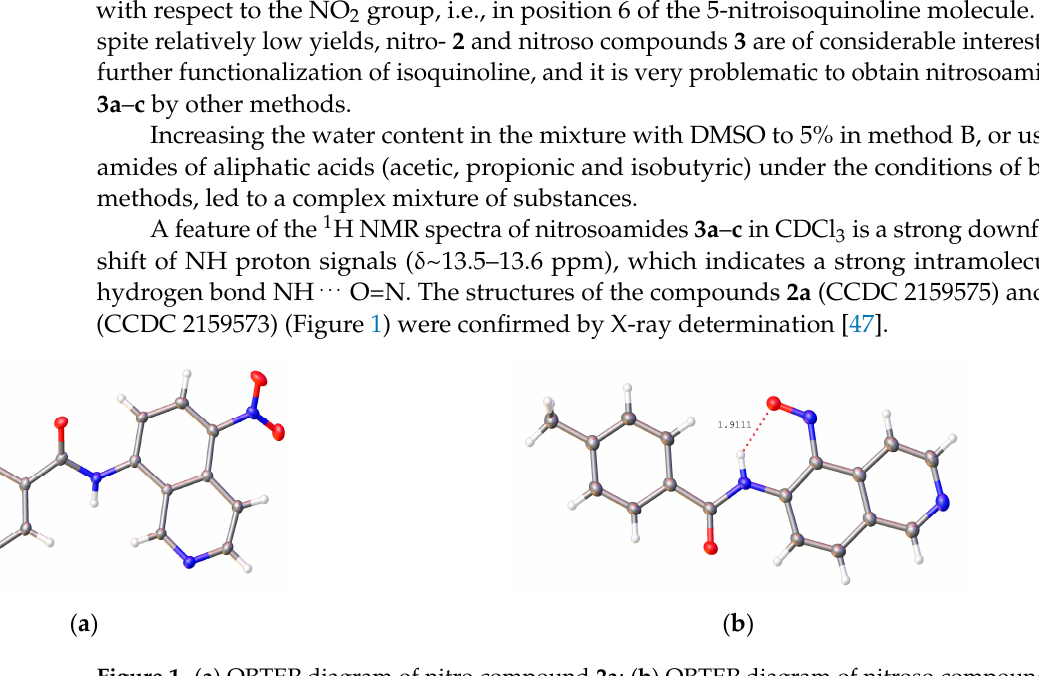
Figure 1. ( a ) ORTEP diagram of nitro compound 2a ; ( b ) ORTEP diagram of nitroso compound 3a (The dashed line shows the intramolecular hydrogen bond). The crystallographic data could be found in the Supplementary Materials.